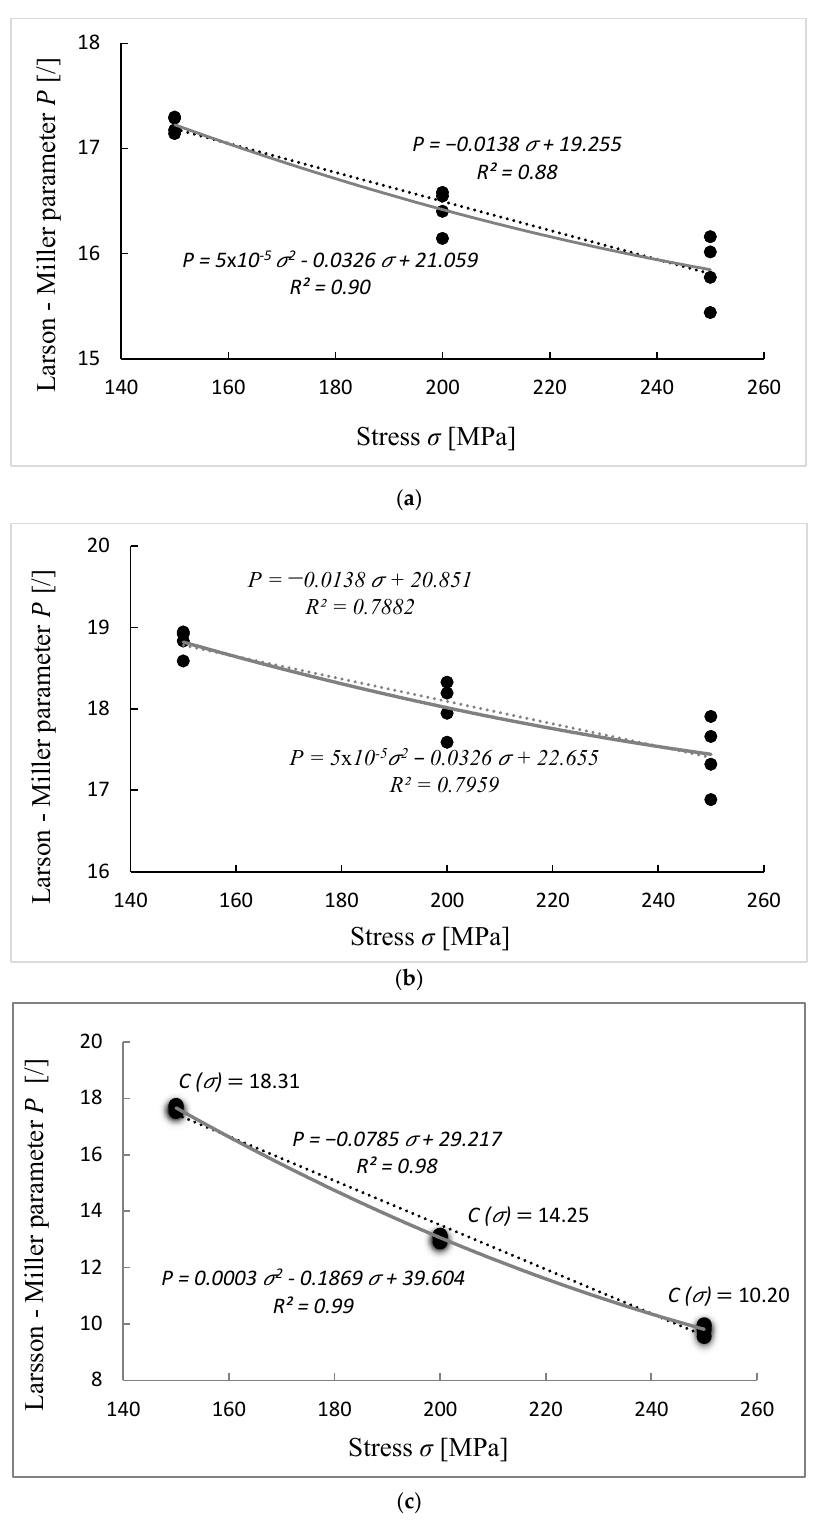
Figure 4. Chart of P vs. stress for different assumptions of parameter C and two extrapolation functions, linear and polynomial: ( a ) C = 18, ( b ) C = 20 and ( c ) C = f ( σ ) . The black points represent the values of parameter P that were calculated according to Equation (5) (for ( a , b )) and Equation (11) (for ( c )), where measured data for temperature, stress and time to rupture (from the National Institute for Materials Science base) have been